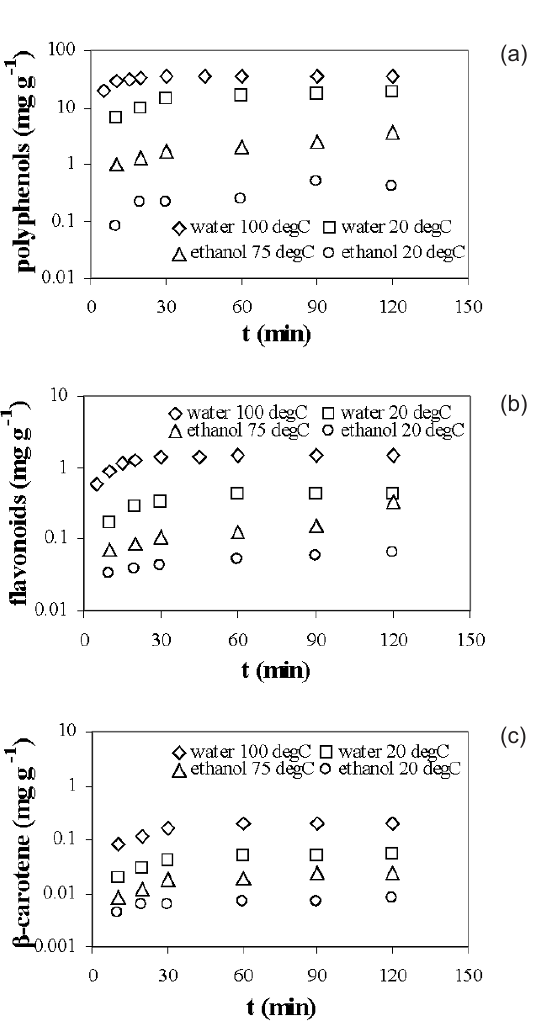
Figure 2. Influence of temperature on the total yield of polyphenols (a), flavonoids (b) and β -carotene (c) extracted with different water-ethanol